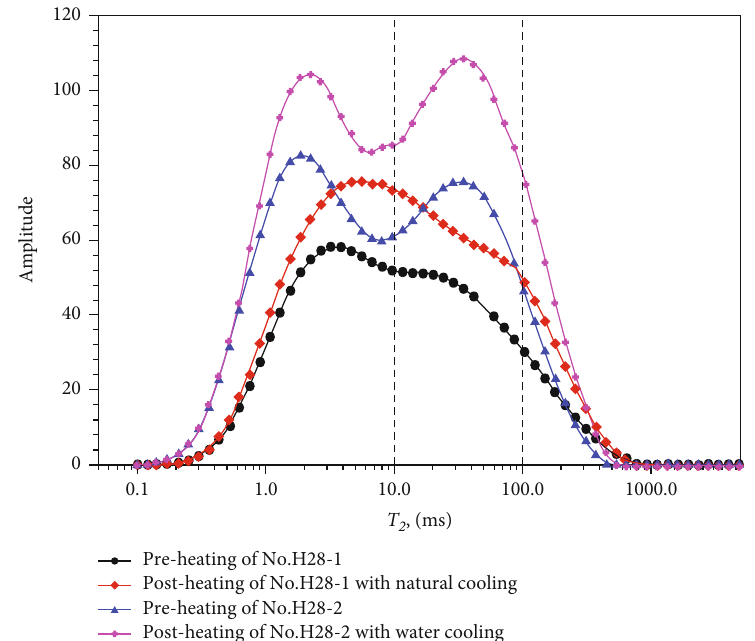
Figure 11: T spectrums and pore size distribution of the core samples (No. H28-1 and No. H28-2) at 400 ° C under two di ff erent cooling 2 methods.